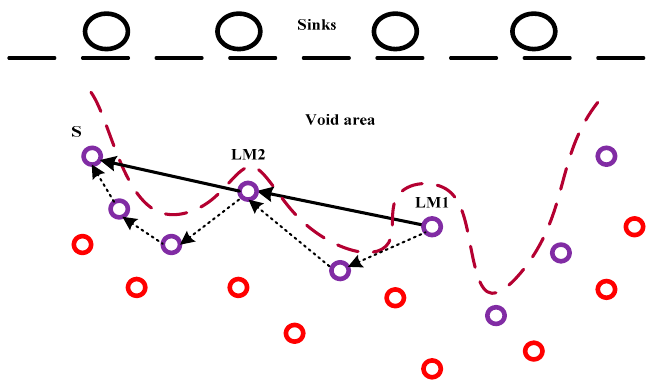
Figure 14. Void handling in HydroCast.